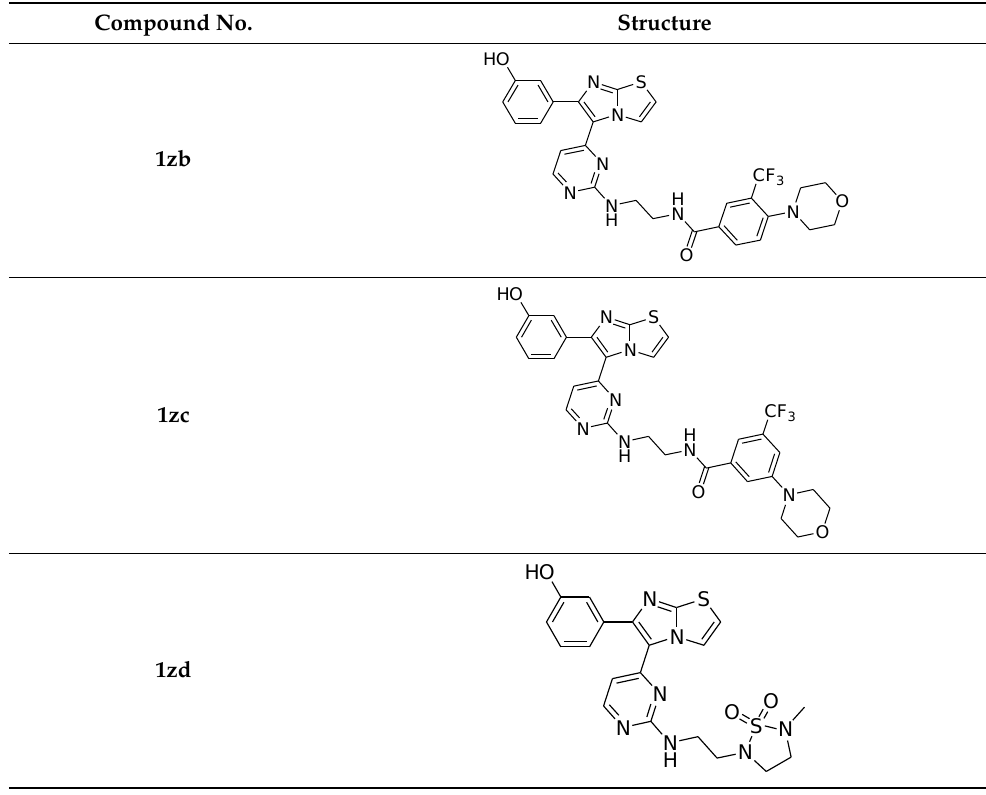
Table 2. Cont. Compound No.